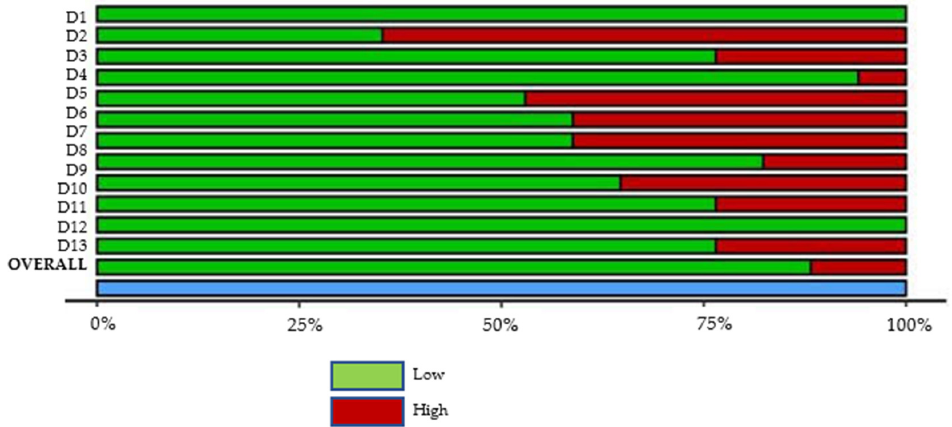
Figure 3. Studies Summary risk of bias plot. D1—Population representativeness ; D2—Target pop-